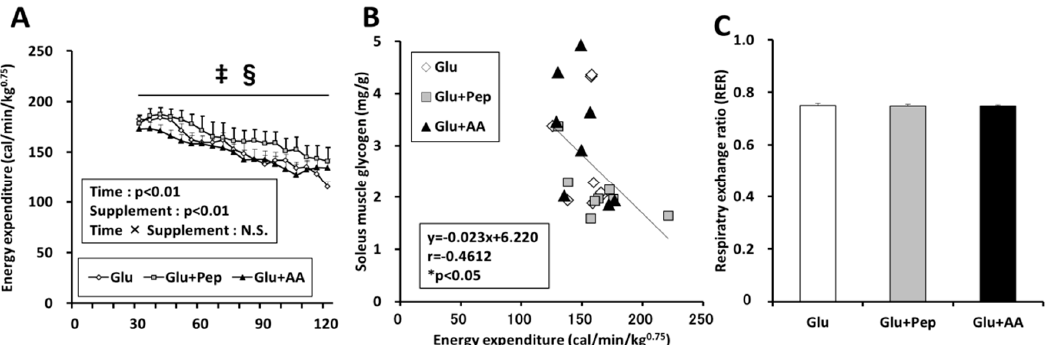
Figure 6. Energy expenditure during the recovery period. ( A ) Energy expenditure during the recovery period; ( B ) Correlation between energy expenditure and muscle glycogen content; ( C ) Respiratory exchange ratio. Values are presented as mean ± SEM. ‡ significantly different from the Glu group ( p < 0.05). § significantly different from the Glu + AA group ( p < 0.05).